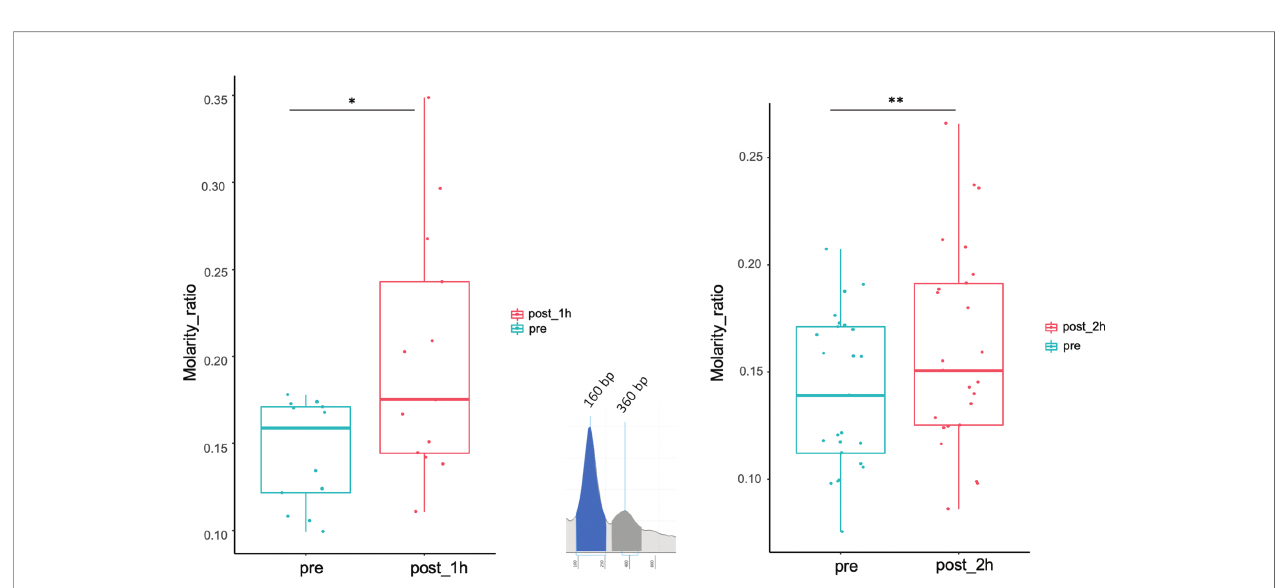
FIGURE 4 | Size shift in post-biopsy ccfDNA vs. pre-biopsy ccfDNA. Boxplots show the molarity ratio between the 360 bp (DNA associated to two consecutive nucleosomes) and the 160 bp (DNA associated with a single nucleosome) peaks obtained by measuring the peak area, one hour and 2 hours from the biopsy procedure. Boxes de fi ne the interquartile range; the central line refers to the median. The number of analyzed individuals in shown below the graph (*P < 0.05, **P < 0.01; Wilcoxon test for paired samples).